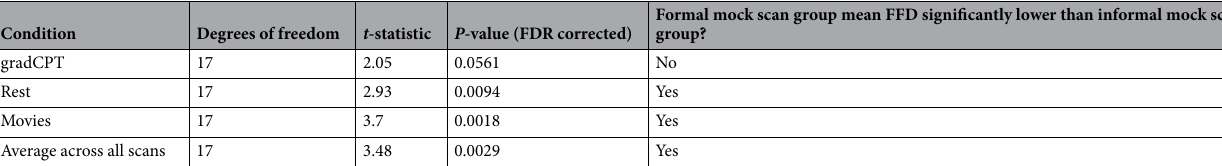
Table 3. Statistical significance of the difference between the grand mean FFD value of the informal and formal mock scan groups.